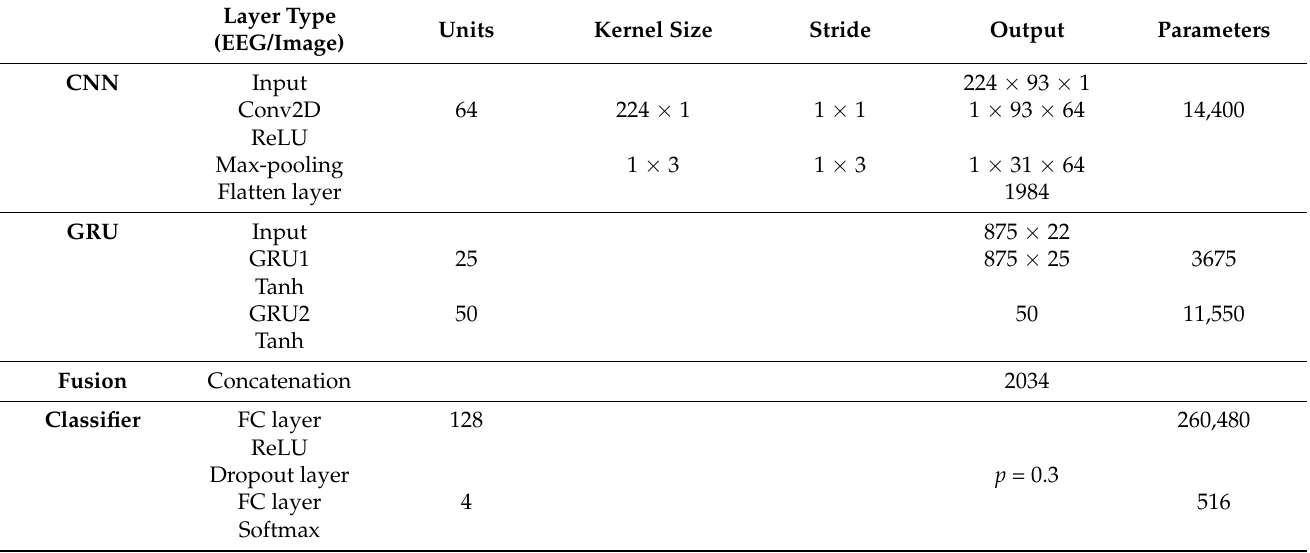
Table 1. Implementation details for proposed GCFN